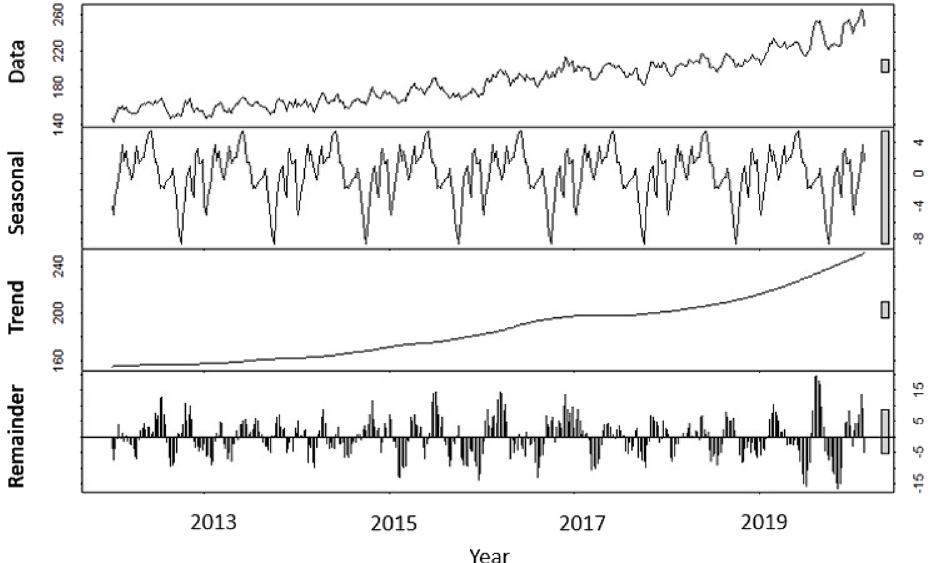
Figure 12. Raw data, seasonal component, trend, and the remainder when the raw data of deceased organ donors is adjusted by removing the seasonal component.